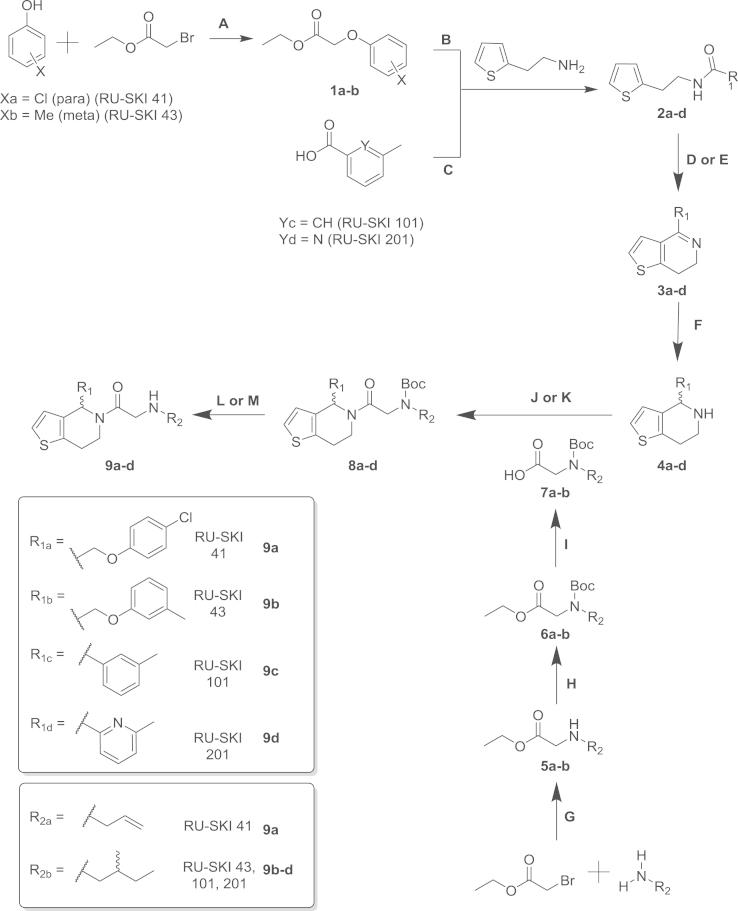
General procedures. (A)
K2CO3, acetone, room temperature,
overnight. (B) NaOMe, MeOH, room temperature, overnight. (C) PyBOP, DIPEA, DMF,
room temperature, overnight. (D) POCl3,
P2O5, toluene, 140 °C,
microwave, 30 min. (E) POCl3,
P2O5, xylene, 85 °C,
2 h. (F) NaBH4, MeOH, room temperature,
1 h or overnight. G. DCM, 0 °C to room
temperature, overnight. (H) TEA, Boc2O, MeOH, 0 °C to 60 °C, 1 h. (I)
1 M LiBH4 in H2O, THF,
room temperature, 1 h. (J) PyBOP, DIPEA, DCM, room
temperature, overnight. (K) EDC, HOBt, DMF, room temperature, overnight. (L)
TFA: DCM (1:1), room temperature. (M) 4 M HCl in dioxane, room
temperature.